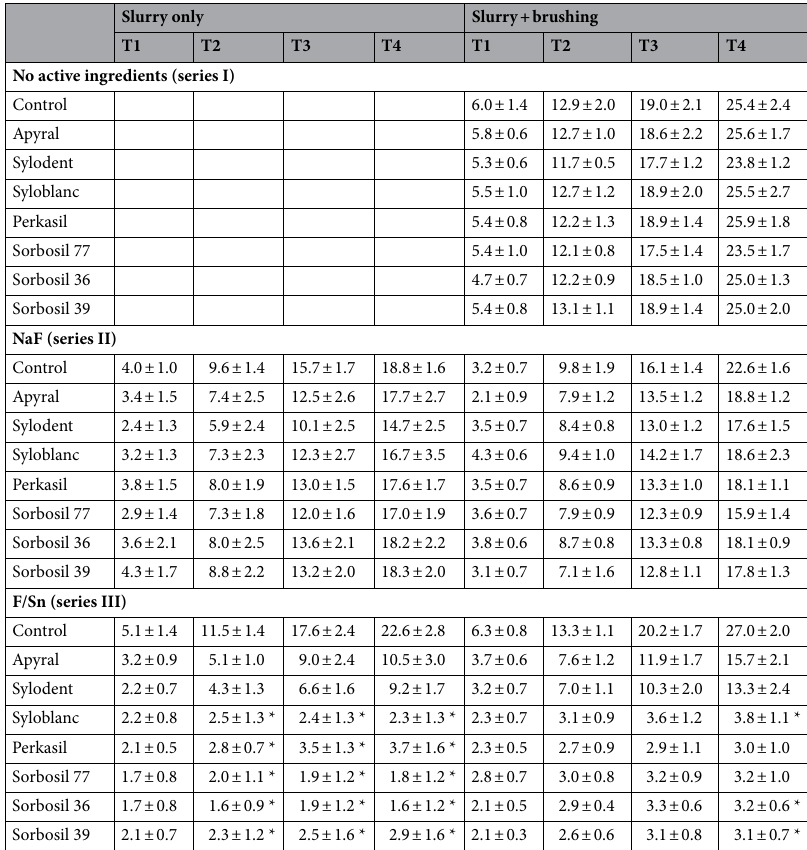
Table 1. Tissue loss values in µm (mean ± SD) after application of slurry only as well as after additional brushing for all time points. Asterisks indicate no significant difference to the time point before (level of significance .002 after Bonferroni